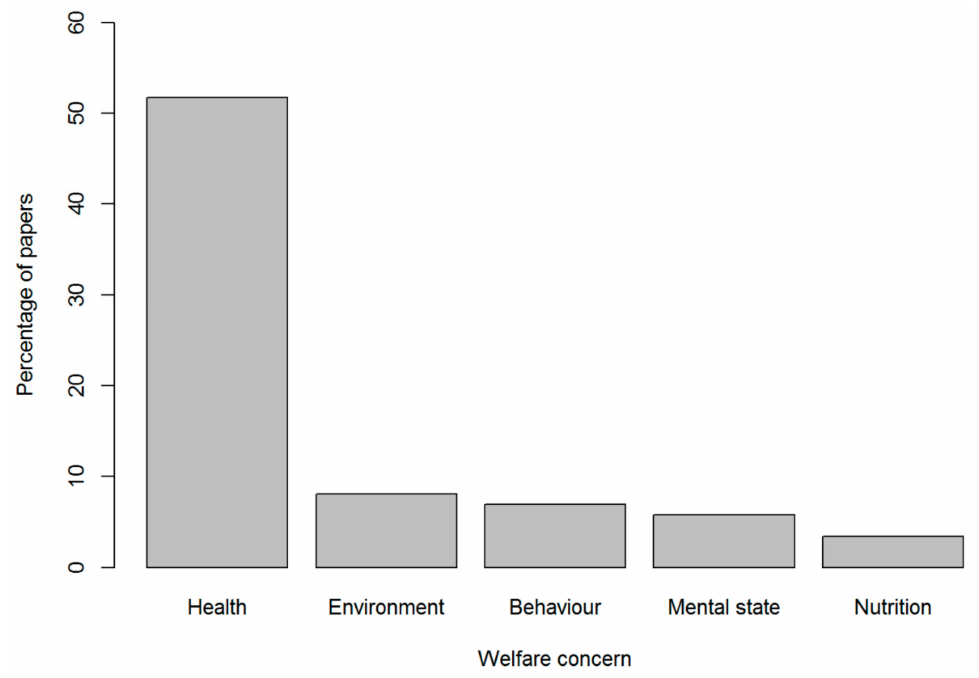
Figure 2. Percentage of papers that identified each of the five welfare